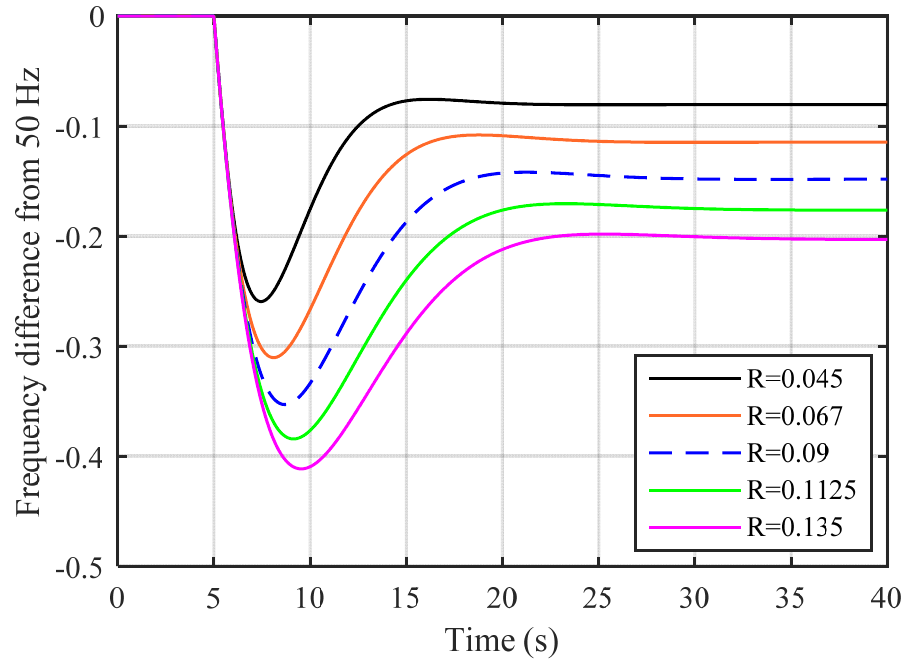
Figure A5. The primary frequency response of GB power system with various values of R.